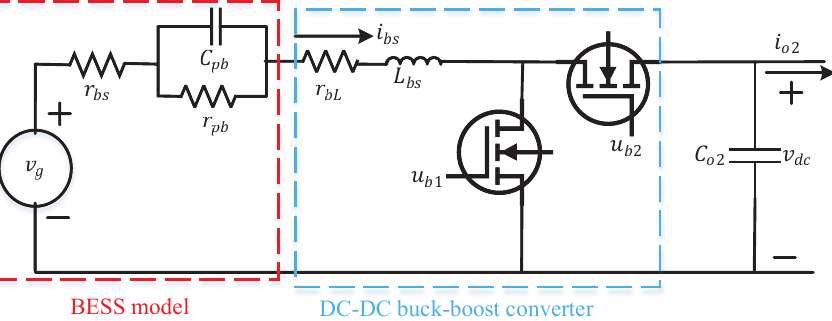
Figure 3. Electrical equivalent circuit representation of a BESS coupled to a bidirectional DC–DC converter. During the operation of the DC microgrid, the SoC of the BESS is limited to SoC BES , max and SoC BES , min , which limit the maximum discharging and charging currents of the BESS in between i bs and i bs , min in order to protect the BESS from over-discharging or over-charging. This situation can be described by the conditions in Equations (4) and